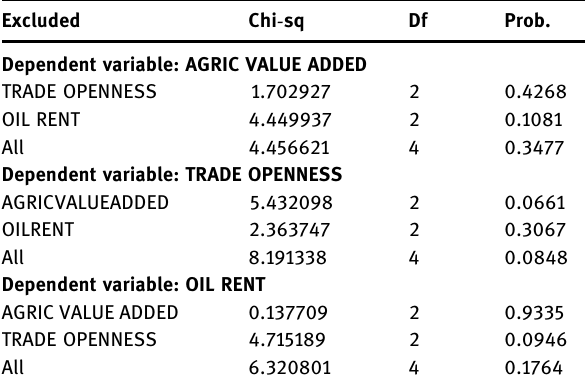
Table 6: Toda - Yamamoto Granger Causality Test Results